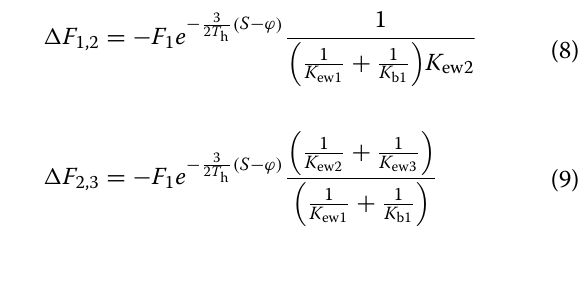
Here, K b1 is the stiffness of the bolt and can be calcu- lated by the equation in Ref. [30]. The sums δ 1,2 δ 2,3 δ b1 can be calculated from Eqs. (6) and (7), respec- + tively, and Δ F 1,2 and Δ F 2,3 can be calculated from Eqs. (8) and (9), respectively: